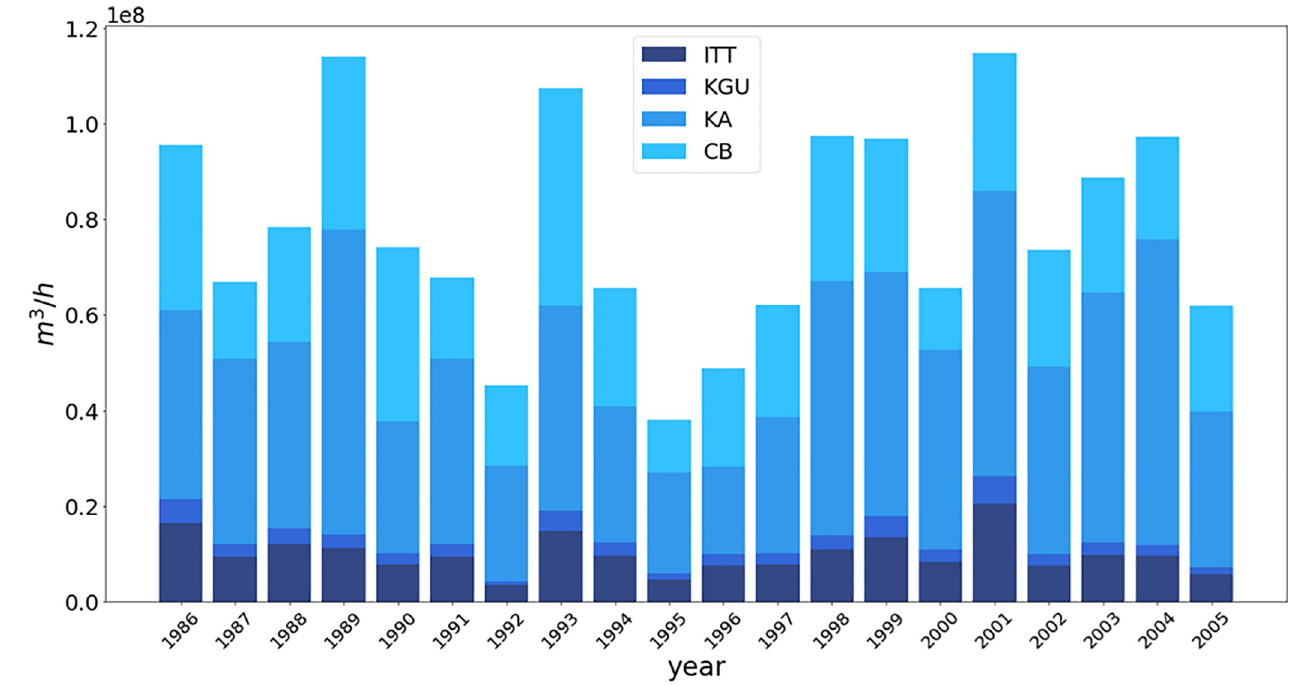
Fig 6. Cumulated historical inflow from 1986 to 2005 for Zambesi River Basin